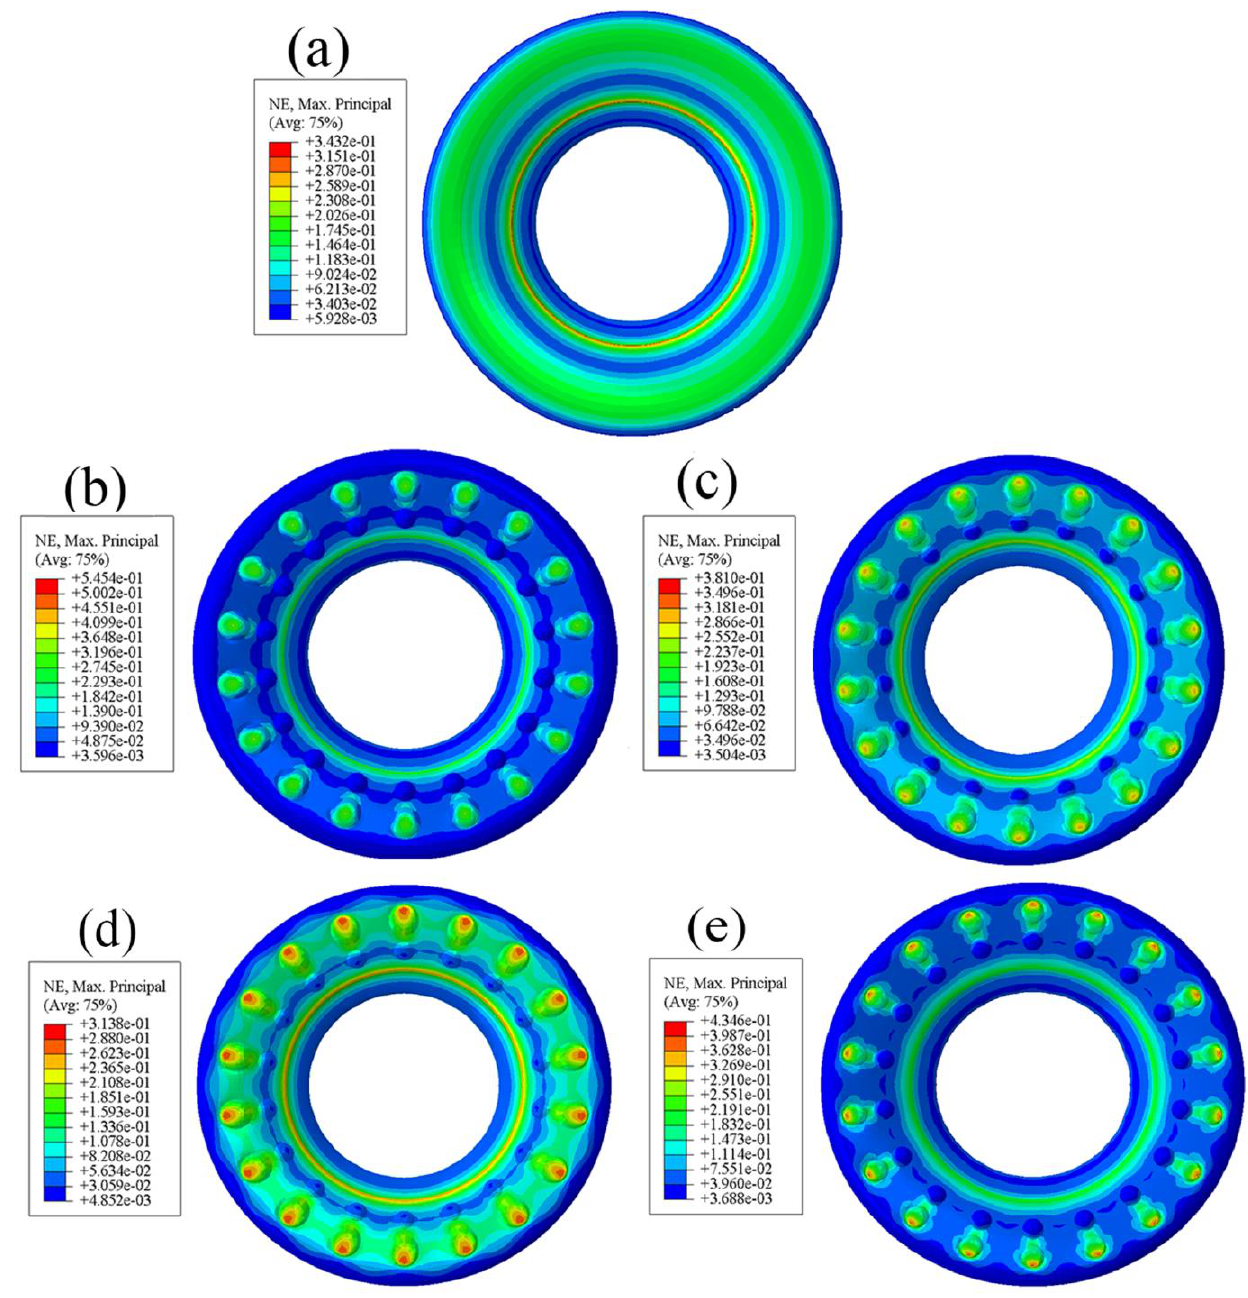
Figure 13. Diagram of contact strain: ( a ) type1; ( b ) type2; ( c ) type3; ( d ) type4; ( e ) standard bushing.